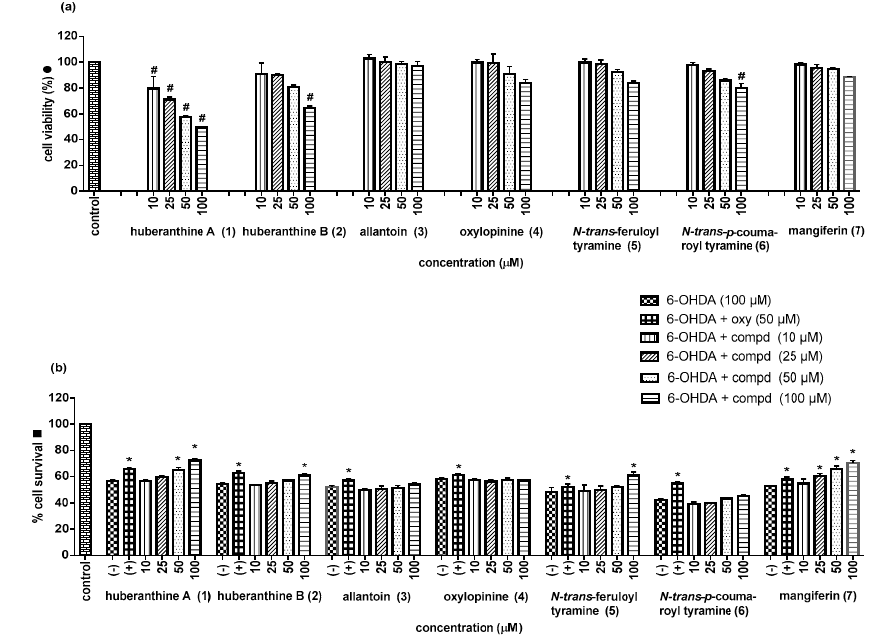
Figure 4. ( a ) Cell viability ( • = 24 h incubation with test sample without 6-hydroxydopamine (6-OHDA)) and ( b ) cell survival ( (cid:4) = 2 h incubation with 6-OHDA after 1 h of pretreatment with test sample); * A p < 0.05 is considered to be significantly di ff erent from the negative control (6-OHDA 100 µ M); # less than 80% cell viability is considered cytotoxic; ( − ) = negative control (6-OHDA 100 µ M); ( + ) = positive control (6-OHDA 100 µ M and oxyresveratrol 50 µ M). N - trans -Feruloyl tyramine ( 5 ) showed a recognizable neuroprotective potential at 100 µM with a 60.9 ± 2.5% cell survival (6-OHDA: 48.4 ± 3.3% at 100 µM). Compounds 3 , 4 , and 6 were devoid of activity. Interestingly, mangiferin ( 7 ) displayed a strong neuroprotective activity, with a 60.5 ± 1.7%